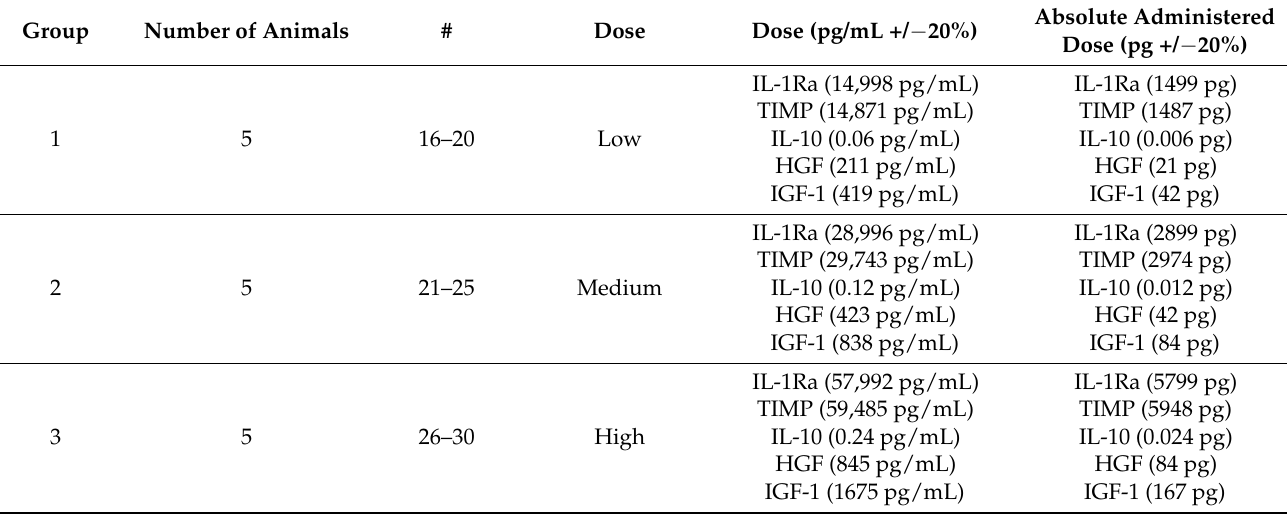
Table 2. Description of 3 groups of animals and doses administered using 5 representative cy- tokines/growth